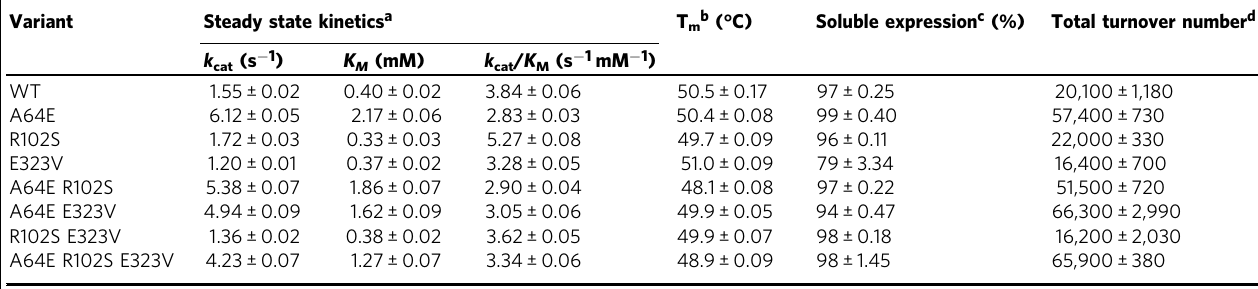
Source data are provided as a Source Data fi le. All values are given with standard deviations from three independent technical replicates. a Steady state kinetics : Buffer: 100mM Glycine-KOH pH 10. Co-substrate: 2.5mM NAD + . Temperature: 22°C. Substrate: R -1-methyl-3-phenylpropylamine 0mM to 12.8mM. Supplementary Fig. 6. b Melting temperature : Differential scanning fl uorimetry with SYPRO orange. Supplementary Fig. 7. c Soluble expression : Protein expression performed at 20°C for 16h. Soluble fraction compared to pellet via gel densitometry. d Total turnover number : Small scale transformation with 50mM 4-phenyl-2-butanone and 0.1 µ M enzyme. Reaction performed at 30°C for 72h with glucose dehydrogenase cofactor